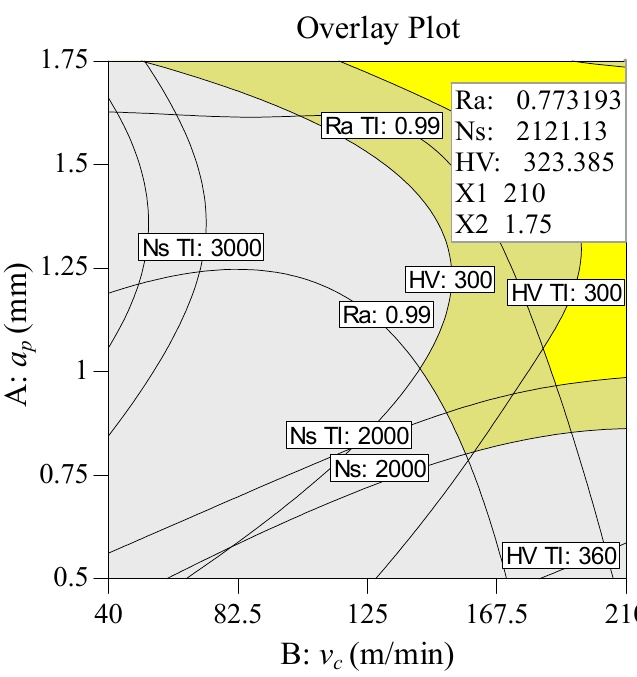
Figure 15. 3D surface plots of composite desirability (LEC mode).